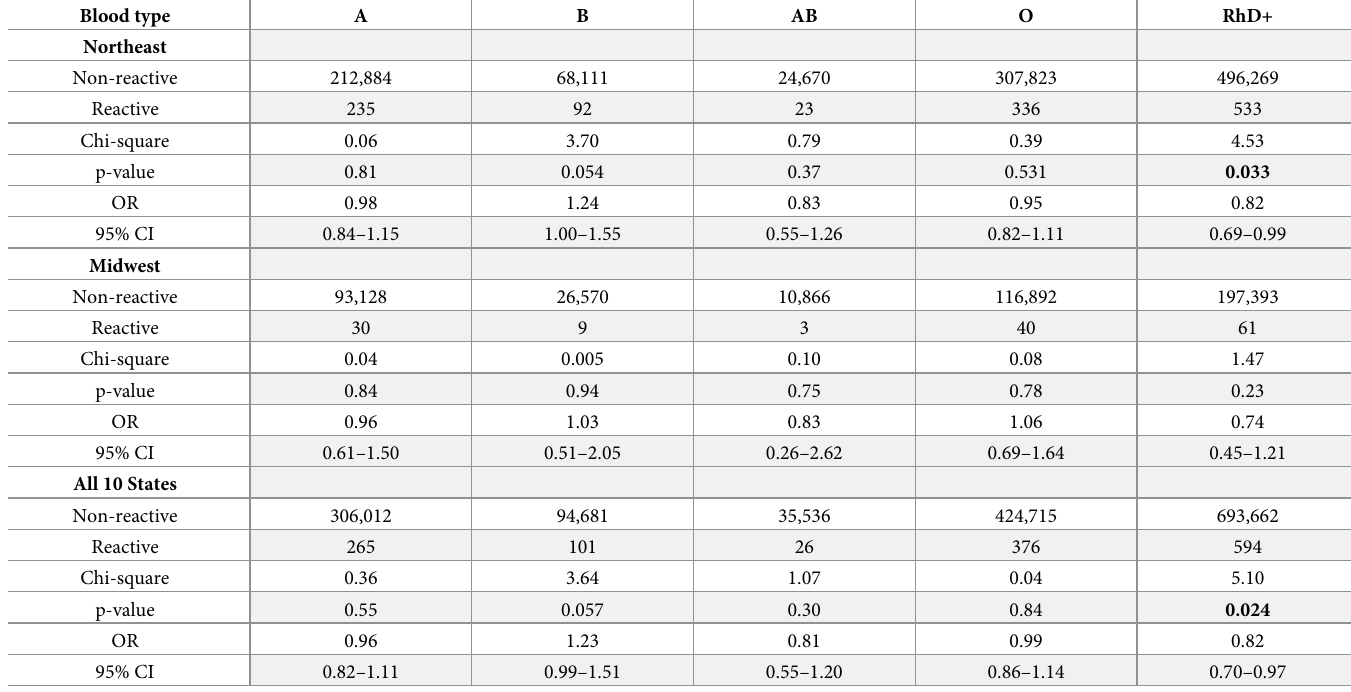
Table 1. Comparing the ABO and RhD blood types of Babesia -NAT reactive and non-reactive blood donors. CI = confidence interval. Blood